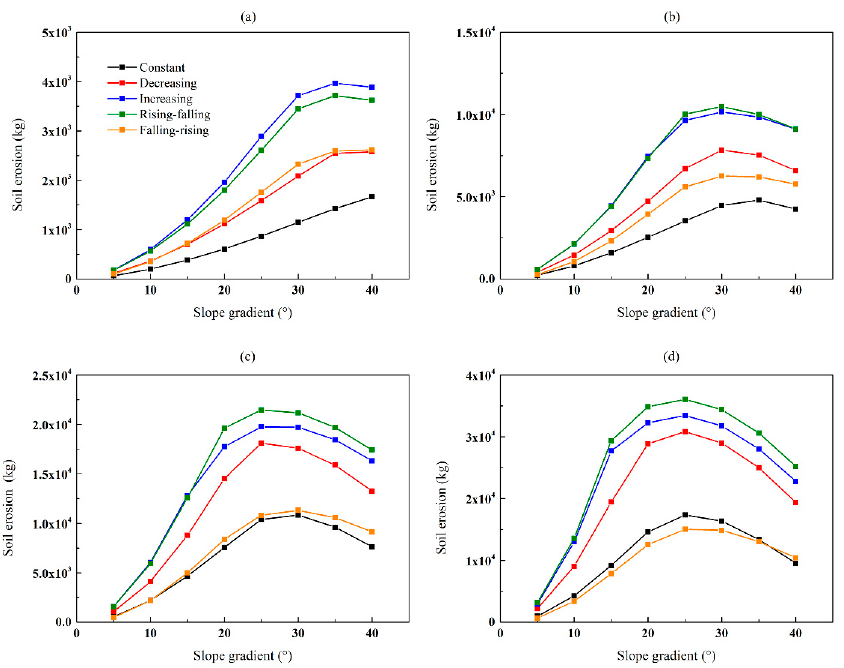
Figure 5. The soil erosion amount at different slopes with projective slope lengths of ( a ) 25 m, ( b ) 50 m, ( c ) 100 m and ( d ) 200 m.